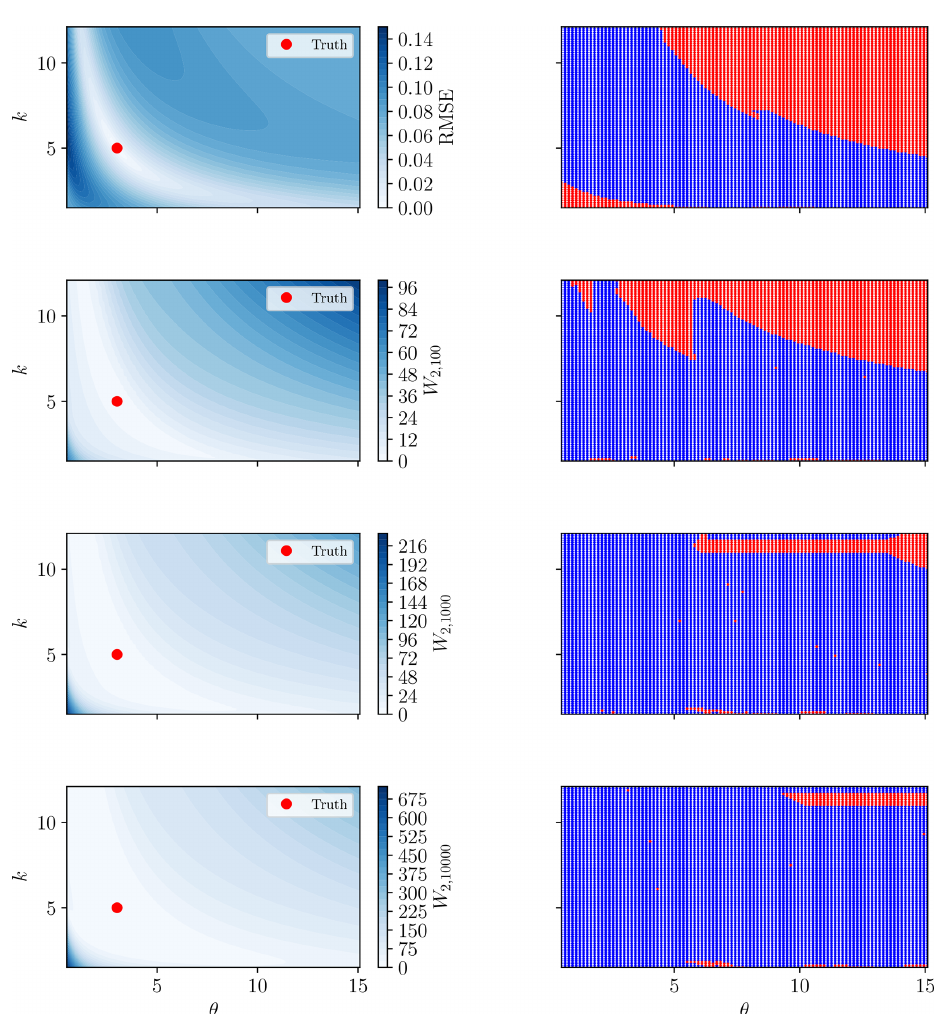
Figure 17. Root mean square error and 2-Wasserstein (with γ = 100, 1000, 10000) misfit surfaces for the rainfall event in Fig. 16 and the unit hydrograph model (Eq. 24) (left-hand-side panels). Red marker shows the true solution. The RMSE surface displays local minima in the lower-left and upper-right corners, where poor convergence is observed. The right-hand-side panels show whether convergence criteria were met (blue) or not (red) for each model